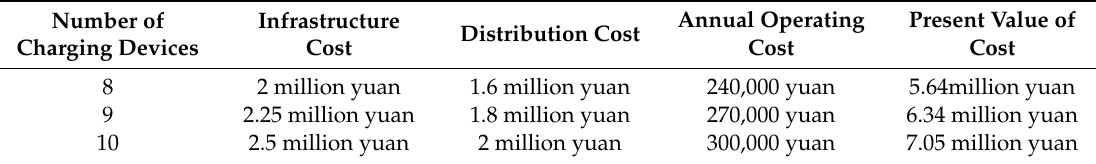
Table 5. Cost distribution under di ff erent numbers.